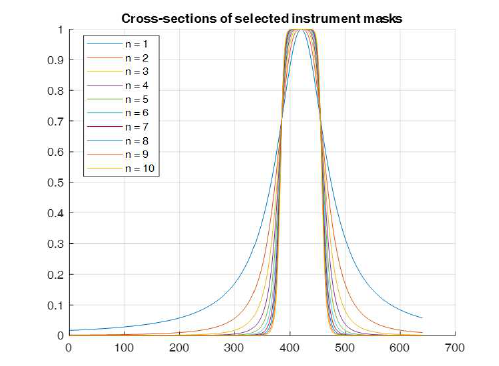
Figure 11. The chosen instrument masks used for the constant radius with decreasing mask profile n from 1, sharp, to 10, smooth.